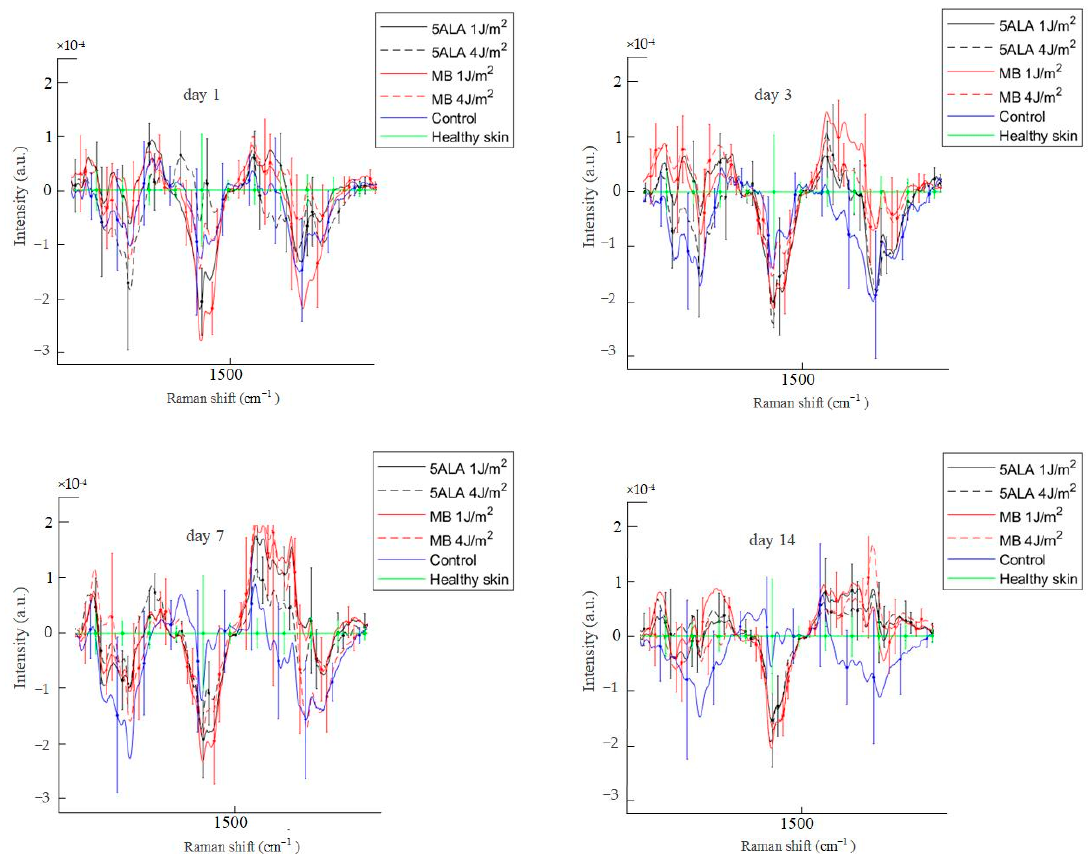
Figure 12. Difference between the wound Raman spectra of all groups subtracting the healthy skin mean Raman spectrum in the 1020–1140 cm − 1 spectral range. The Raman spectra are presented in terms of mean ± StD values. Black line—5ALA 1 J/cm 2 , black dashed line—5ALA 4 J/cm 2 , red line—MB 1 J/cm 2 , red dashed line—MB 4 J/cm 2 , blue line—control, green line—healthy skin (the number of processed Raman spectra was equal to 30 for each group).